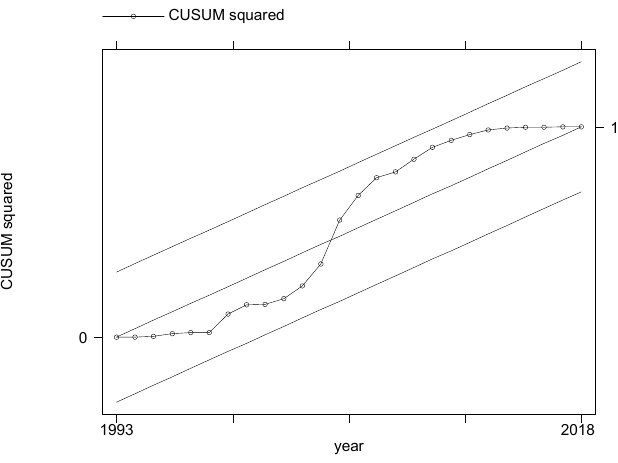
Figure 6. CUSUMQ for Model 1.